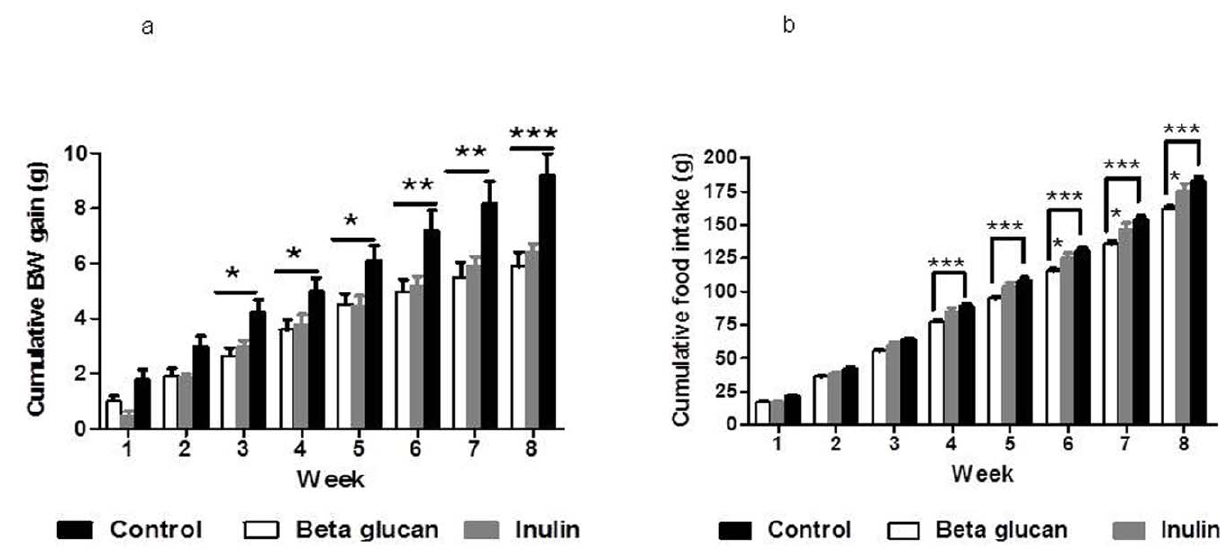
Figure 2. The effect of inulin and b -glucan supplementation over the 8-week dietary interventional period (a) weekly cumulative body weight gain, n=12 per group (b) weekly cumulative food intake over the 8 week dietary intervention period, n=12 per group. *=p , 0.05, **=p , 0.01, ***=p , 0.001. Key: HFD-C, high fat diet control; HFD-I, high fat diet + inulin; HFD-BG, high fat diet + b -glucan. doi:10.1371/journal.pone.0043263.g002 Epididymal fat mass was significantly lower (p , 0.05) in HFD-I, while cecal weight (along with contents) was significantly higher (p , 0.001) in both HFD-I and HFD-BG, compared with HFD-C (n =6 per group, Table 1). The cecal weight of HFD-BG mice was significantly lower than that of HFD-I mice (p , 0.01). Liver and colonic weights did not differ significantly.